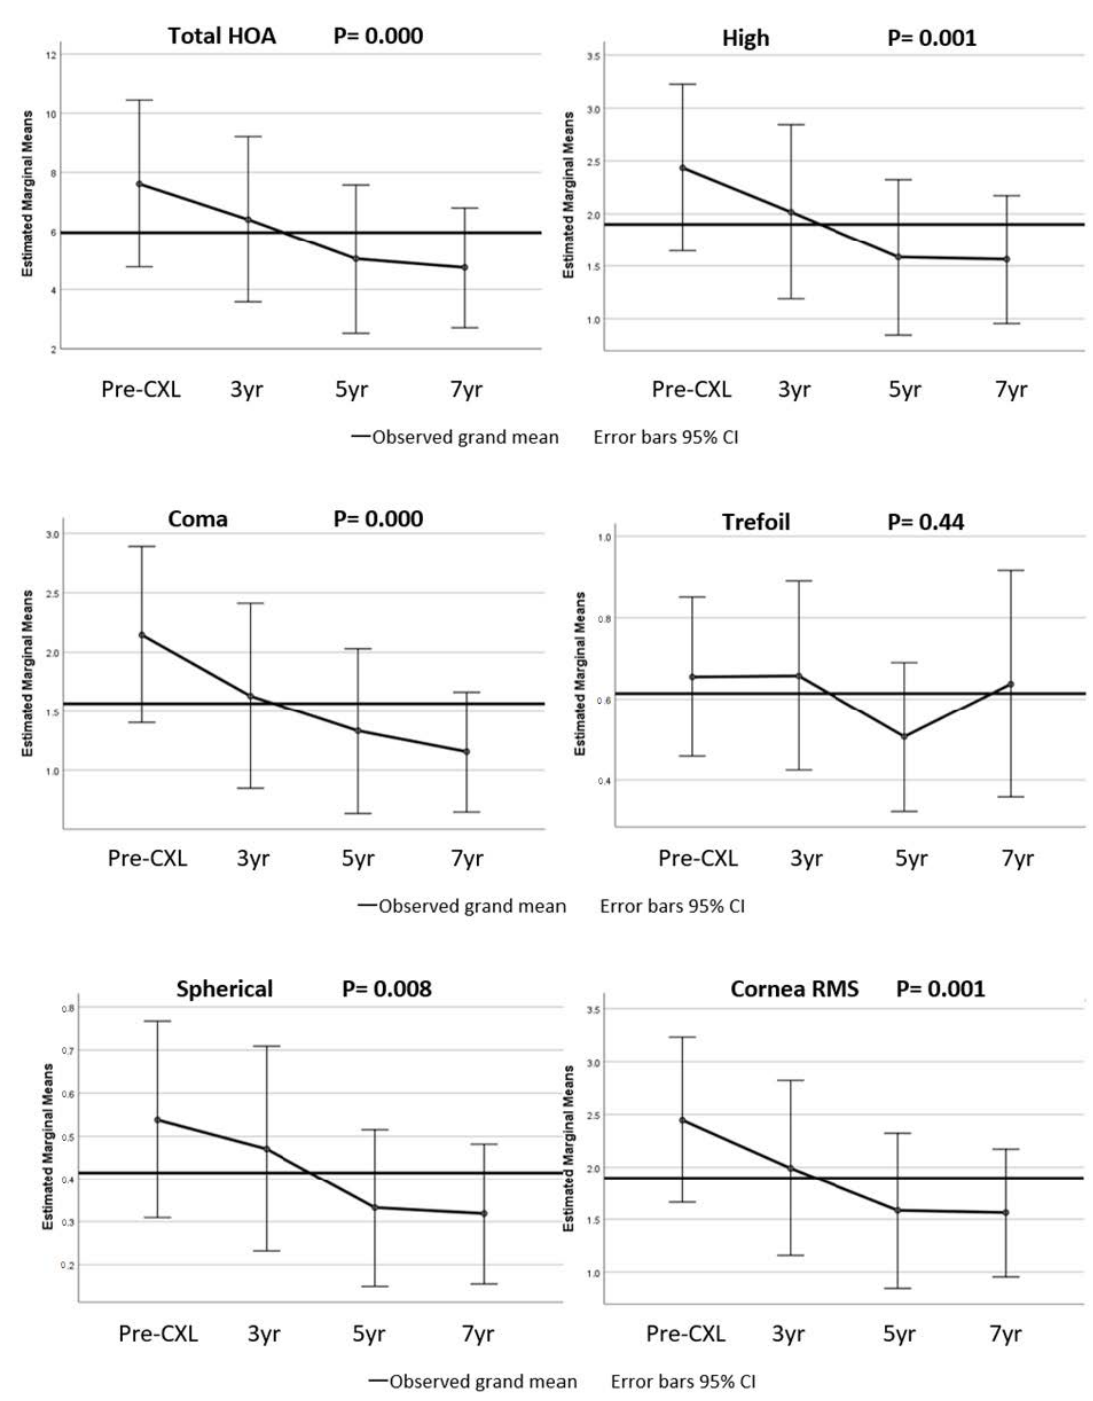
Figure 3. Change in corneal wavefront aberrations and corneal RMS from the pre-crosslinking (CXL)